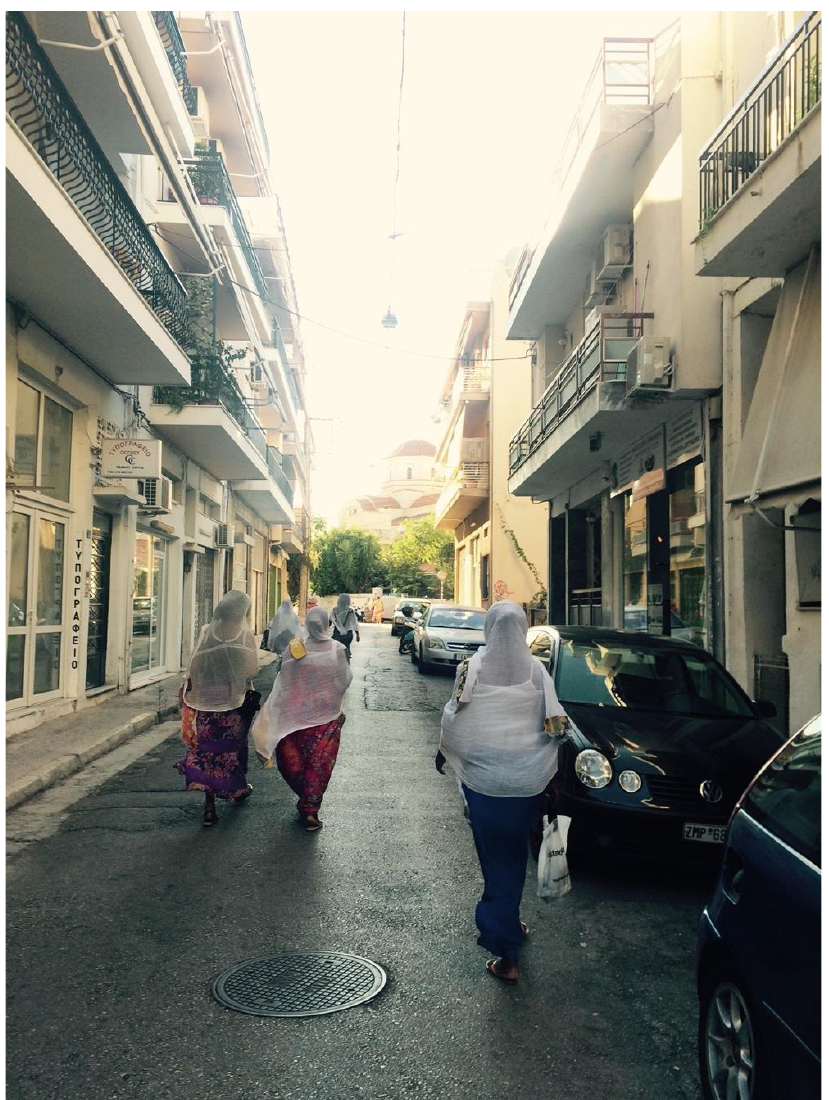
Figure 5: Women on their way to a blessing ceremony, Polygono neighbourhood, Athens. (photo: Viki